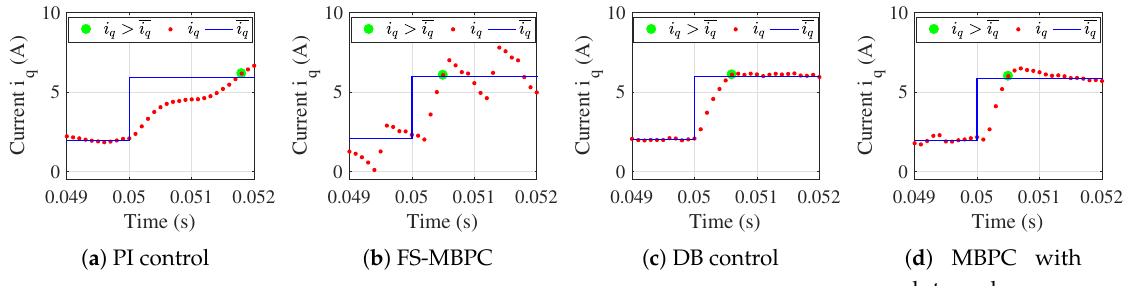
Figure 13. Measured rise time of the controllers under healthy working